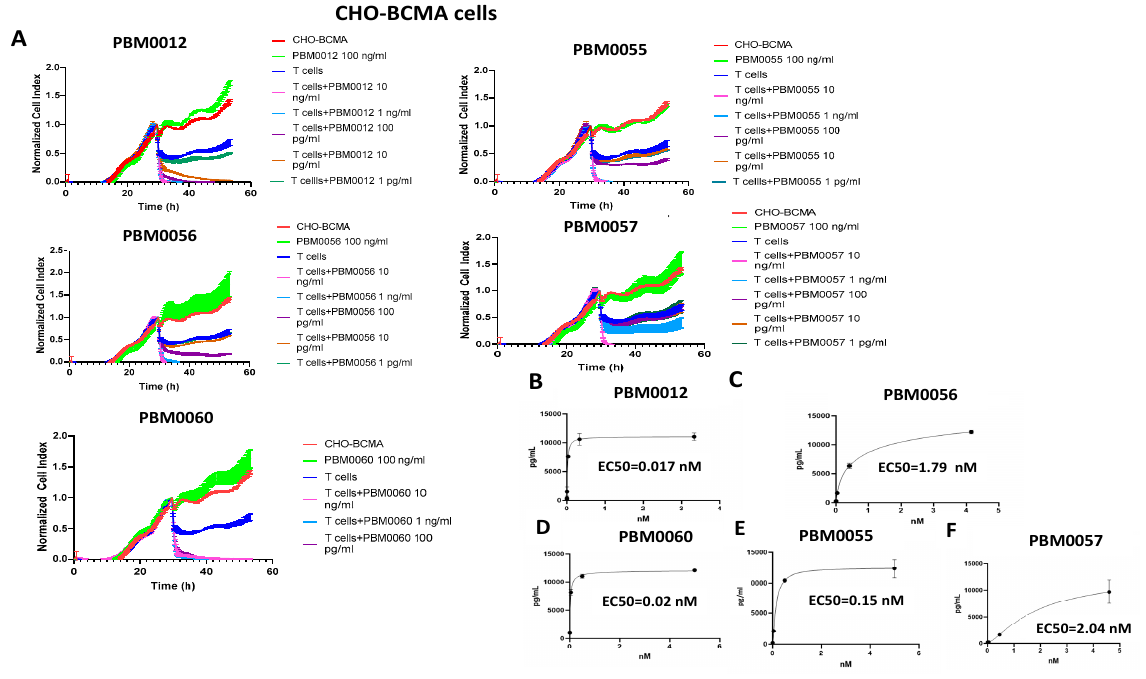
Figure 3. T cells with BCMA-CD3 antibodies effectively killed CHO-BCMA cells and secreted IFN- gamma. ( A ) RTCA killing assay with T cells and BCMA-CD3 antibodies against CHO-BCMA target cells. ( B – F ) IFN-gamma secretion by T cells with BCMA-CD3 antibodies and CHO-BCMA target cells. EC50 for each antibody is shown in nM. Representative RTCA and IFN-gamma assays are shown.